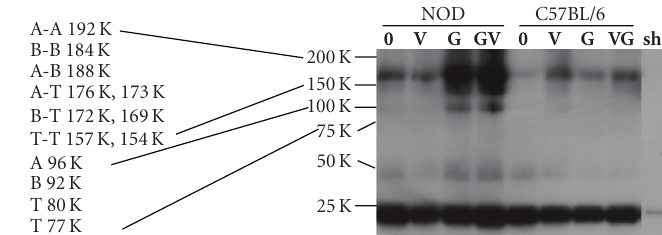
Figure 3: STAT5 binding to chromatin increases after GM-CSF stimulation in NOD but not C57BL/6 bone marrow cells. Five million bone marrow cells were cultured with or without 100 μ M Na vanadate for 30 minutes at 37 ◦ C/5CO 2 . Half of the cultures+ / − vanadate were then supplemented with 1000 U/mL GM-CSF, and all were incubated for an additional 90 minutes at 37 ◦ C/5CO 2 . The cells were then fixed in situ , extracted, and sonicated. The sample was split into five 1 × 10 6 cell aliquots for use in anti-STAT5Ptyr/anti-Histone H3-mediated double ChIP protein isolations for Western blot analysis of STAT5 associated with histone/chromatin complexes. Protein isolated from the precipitated chromatin complexes and analyzed by Western blot probed with anti-STAT5Ptyr antibody. Densitometric/Rf-value anti-STAT5Ptyr Western blot-detected bands separated on 4-20% SDS-PAGE were used to give the approximate size and location of the STAT5 protein complexes and monomers (approximate molecular weights indicated on the left of the figure). Higher molecular weight bands that bound the anti- STAT5Ptyr antibody had Rf values suggesting that they may represent a mix of formaldehyde-cross-linked dimer complexes containing mixed isoforms of STAT5 (STAT5A (A 96K), STAT5B (B 92K), and truncated (T 80 K, 77K)), both in homodimers (A-A 192 K, B-B 184K, T-T) and heterodimers (A-B, A-T, B-T, T-T) complexes. Only monomeric STAT5A size bands (96K) are detected in the GM-CSF-induced NOD cell cultures at this early time point. The positions of the precipitating antibodies heavy chain (50K) and light chain (25 K), which acts as an internal protein loading standards, were determined from the extract minus sham control ( sh ) and size standards (indicated but not shown). Treatment/lane key: 0 = untreated, V = vanadate alone, G = GM-CSF alone, VG = vanadate and GM-CSF-supplemented 2-hour cultures. Data represents 3 runs of the double ChIP